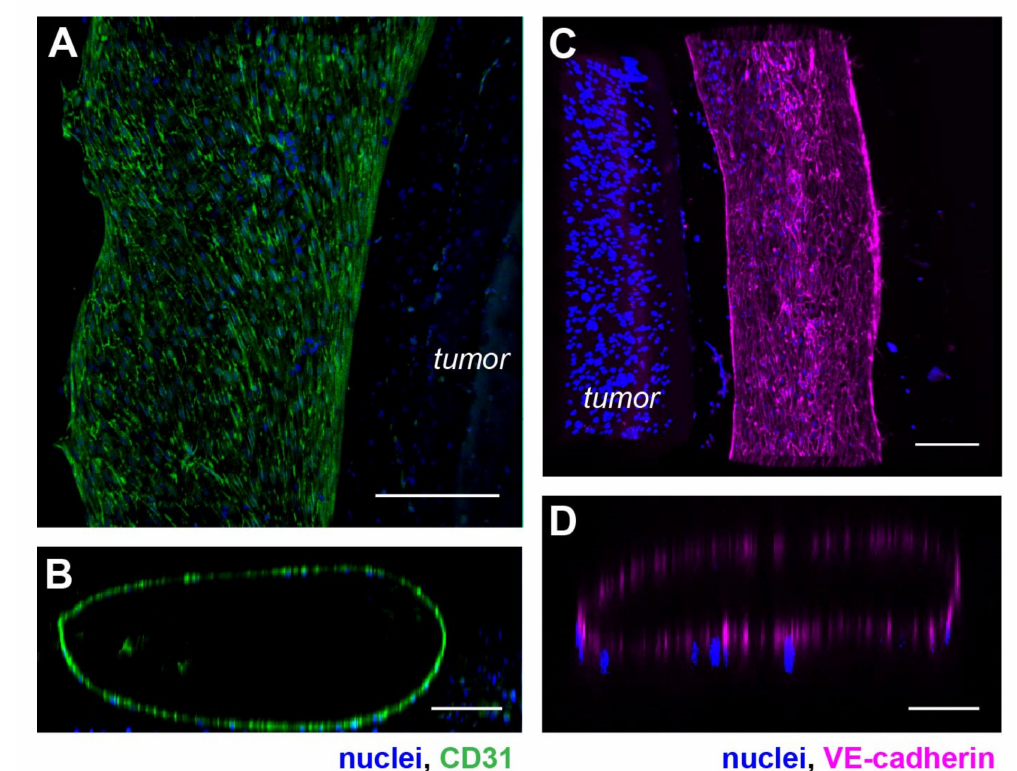
Figure 2. Phenotypic characterization of the vasculature in hypoxic SKOV3 tumor model. ( A ) Top view of a 3-D vasculature surrounding a tumor section reconstructed from confocal scans after CD31 immunostaining in HUVEC. Blue: nuclei. ( B ) A vertical volume-rendered cross section reconstructed from confocal images showing a hollow lumen surrounded by an endothelial layer. ( C ) Top view of a 3-D vasculature surrounding a tumor section reconstructed from confocal scans after immunostaining of VE-cadherin in the tumor model with nuclear counterstain. ( D ) A vertical, volume-rendered section reconstructed from VE-cadherin confocal scans. Scale bars: ( A , C ) 250 µ m; ( B , D ) 100 µ